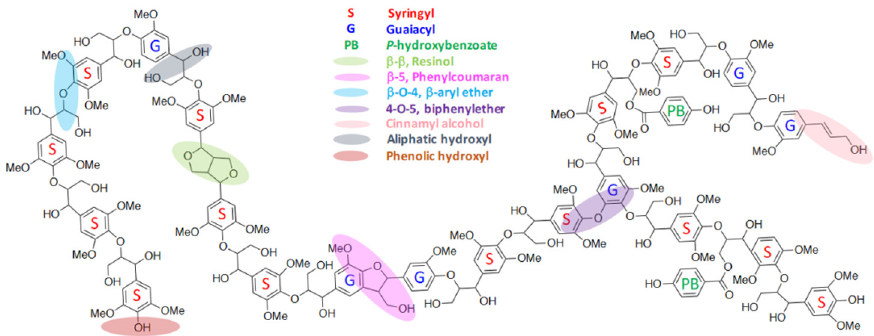
Figure 4. Example of hardwood lignin structure representation [30].